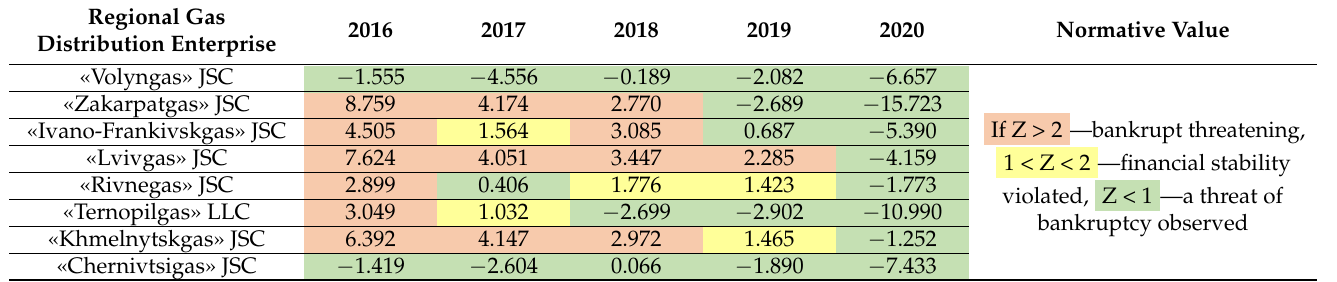
Table 9. Tereshchenko’s model approbation.